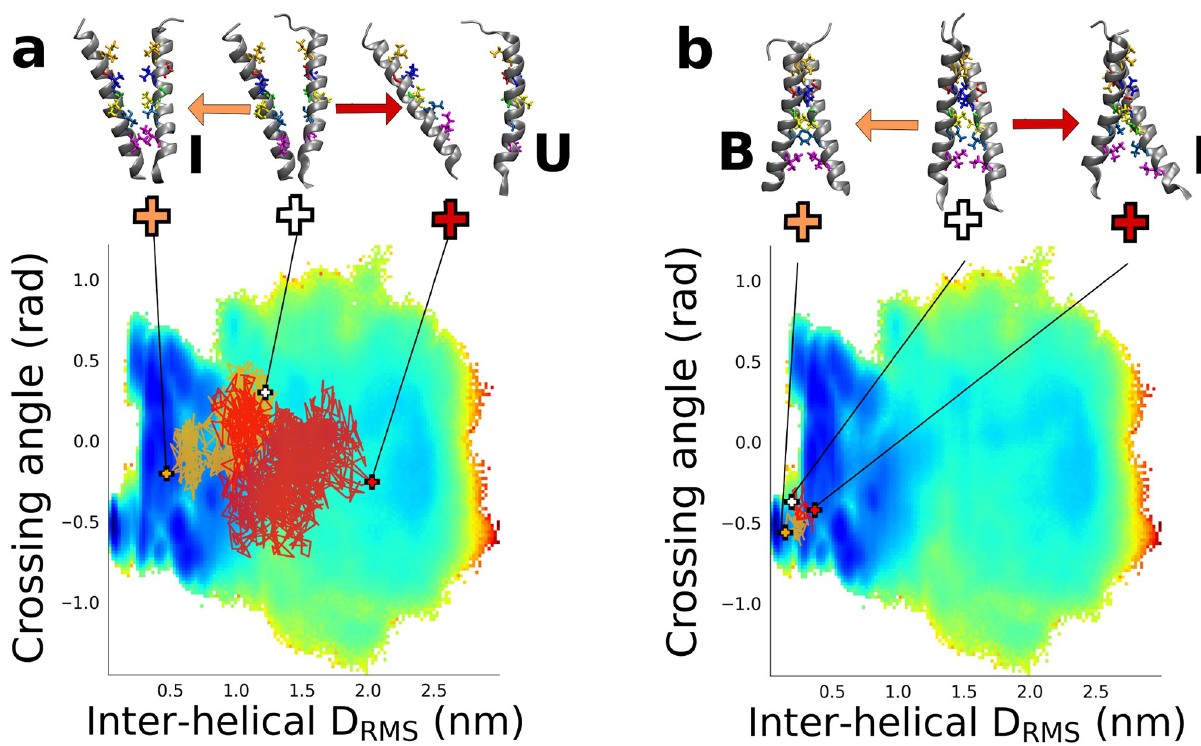
Fig 3. Transition paths for binding. (a) Transition paths for crossing the first barrier from U to I and projected onto the binding free energy surface. The “forward” and “reverse” halves of each trajectory are coloured light and dark brown respectively. Structures above plot illustrate the initial structure (center) and “forward” (left) and “reverse” (right) endpoints, ending in I and U respectively. Side-chains of key residues forming the native binding interface are shown in colour. (b) Same as for (a), but for crossing the second barrier from I to B.